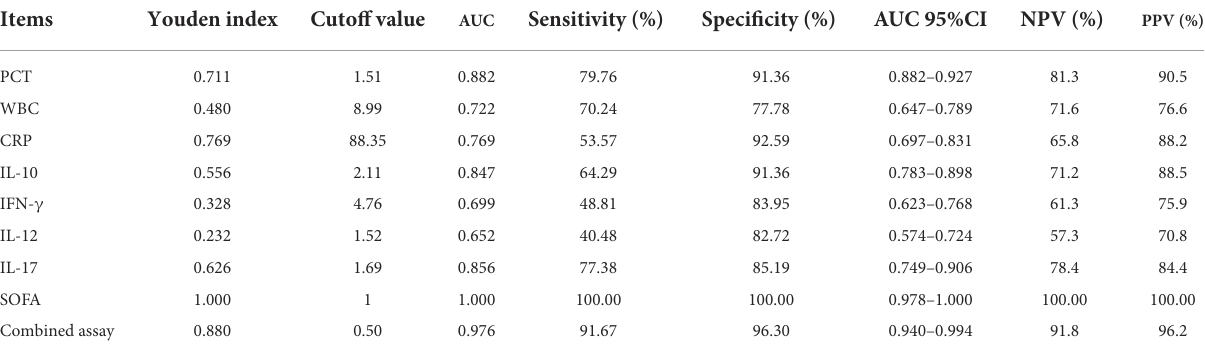
TABLE 2 Comparative analysis of the results of each index in patients in the sepsis and infection groups.